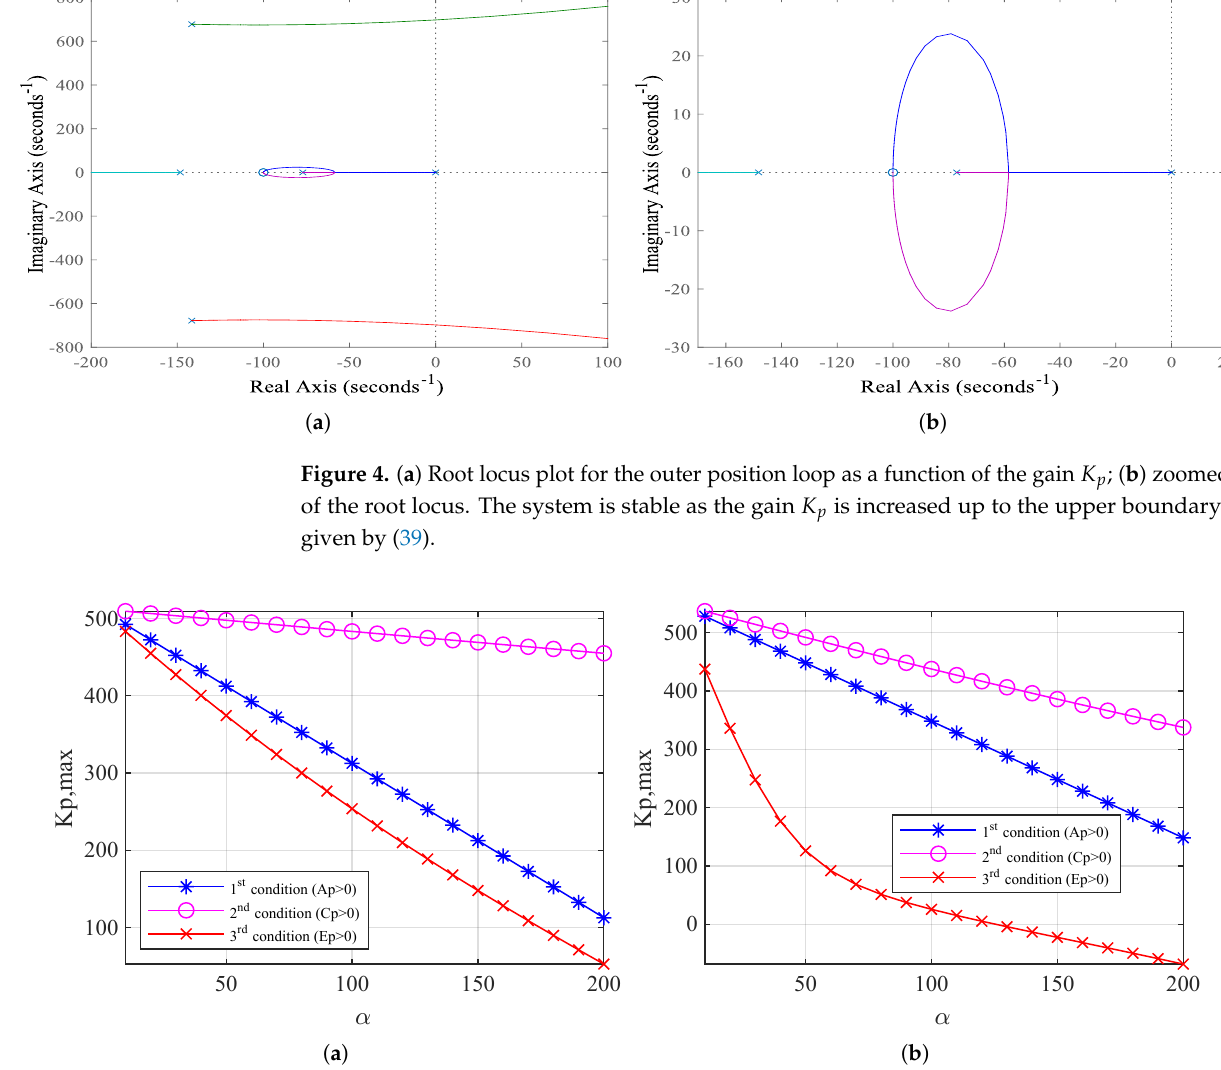
Figure 5. Maximum boundary conditions for the gain K p as a function of α for f 0 = 1.0 Hz and ( a ) K v = 100, ( b ) K v =